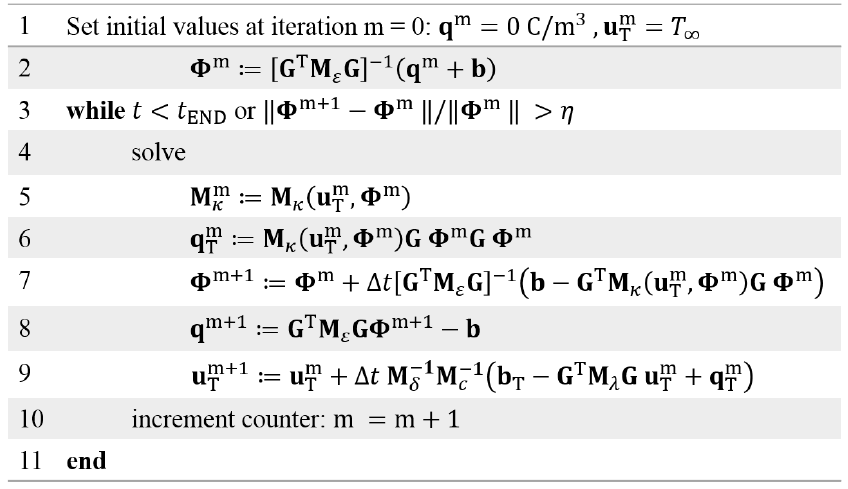
Figure 4. Numerical computation scheme, to obtain the electric field and the space charge density, using the space charge-oriented field formulation (8)–(10) [11,58,59].